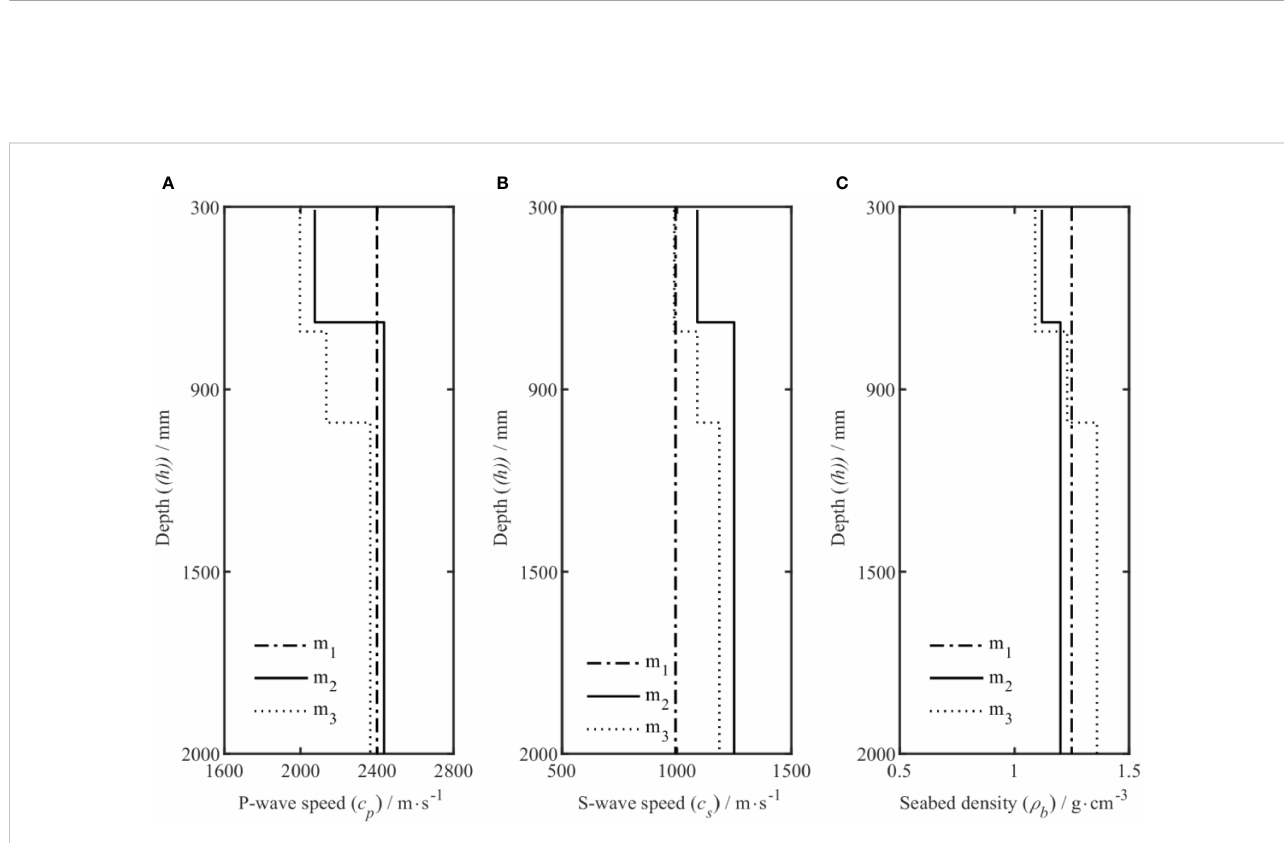
FIGURE 11 Density, compression wave speed, and shear wave speed pro fi les from the model selection study, where m 1 , m 2 , and m 3 represent the inversion model of the 1-layer, 2-layer, and 3-layer uniformly distributed seabed, respectively. (A – C) Relationship of c p , c s , and r with depth,